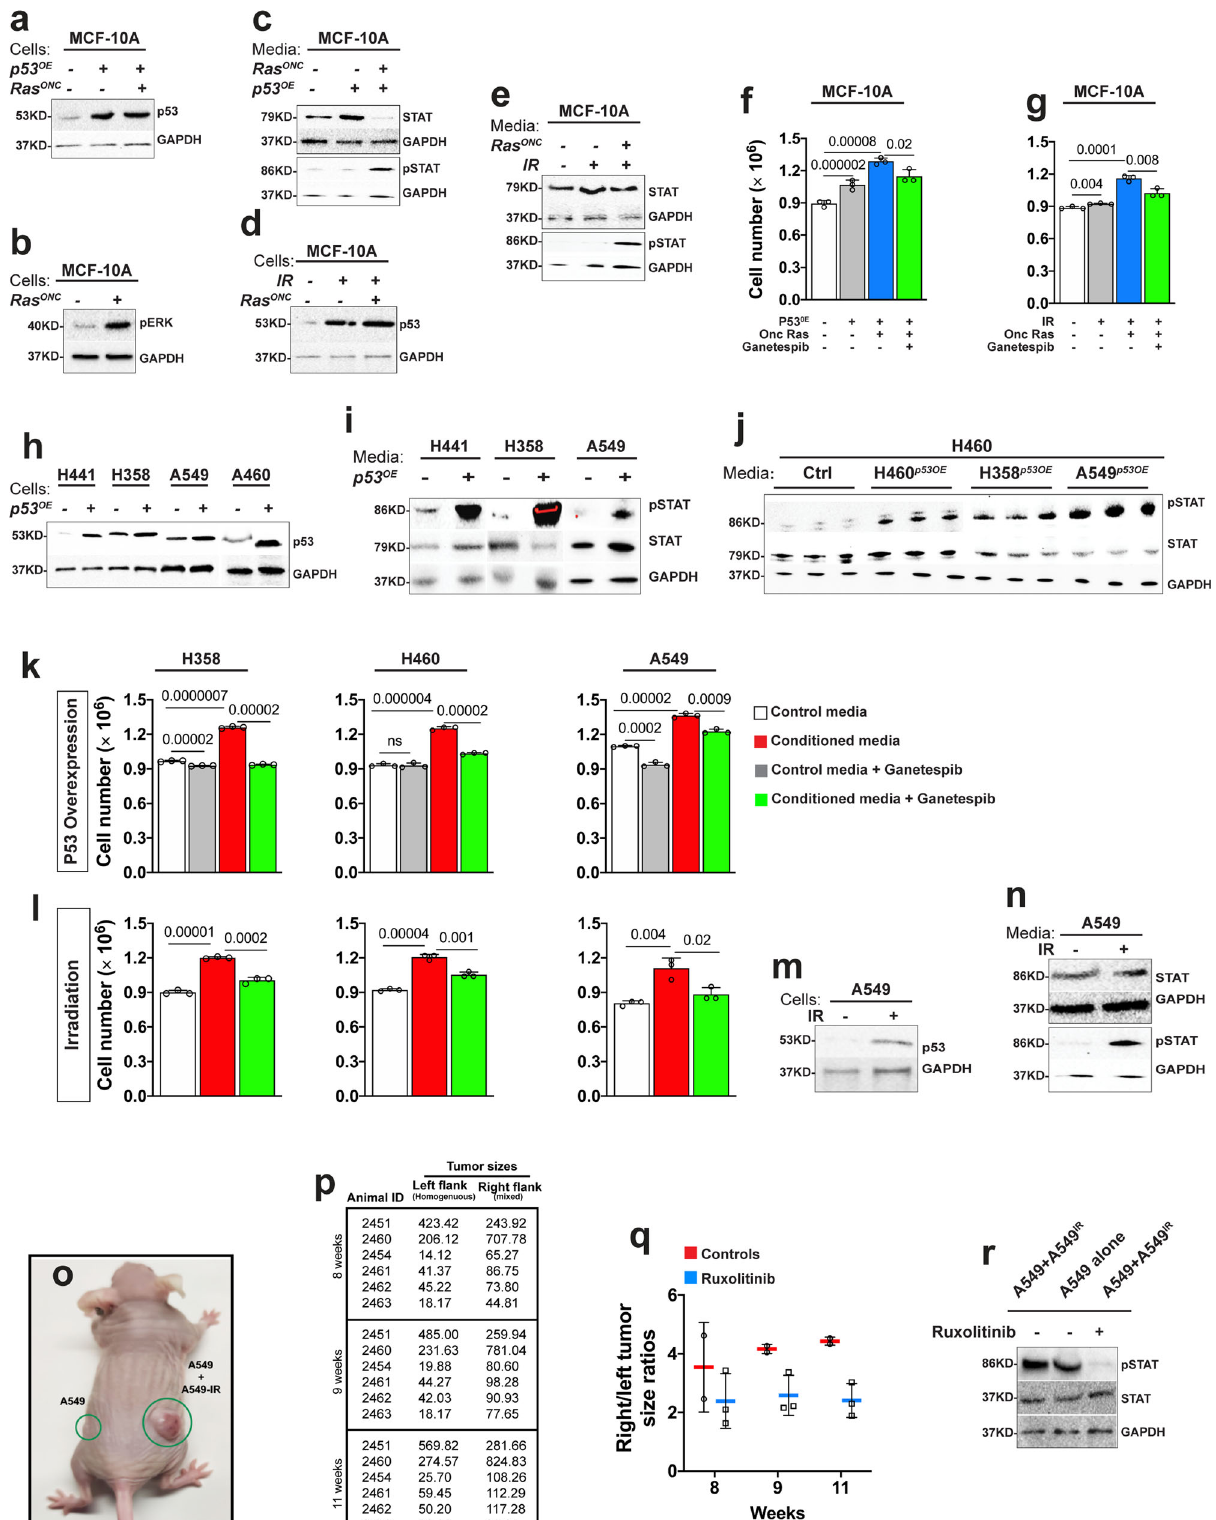
IR transcriptionally stimulates all unpaired cytokines ( upd1-3 ) (Fig. 5e). Similar to ptip − / − -induced upd stimulation, IR- triggered upregulation of upd cytokines in Ras V12 cells was lost when we introduced dominant-negative dp53 ( p53 R155H ) (Fig. 5f). Collectively, our data indicate that irradiation transcriptionally induces the production of upd cytokines downstream of